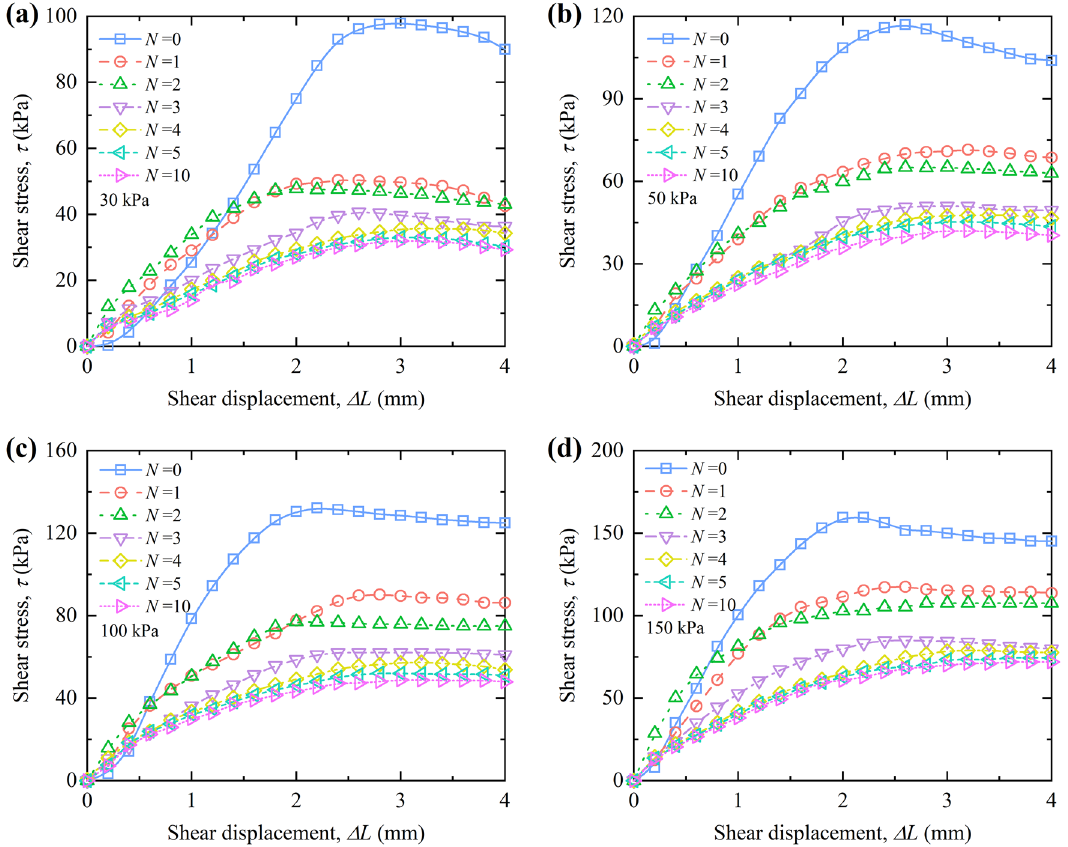
Figure 11. Shear stress versus shear displacement curves of BML under vertical pressure.